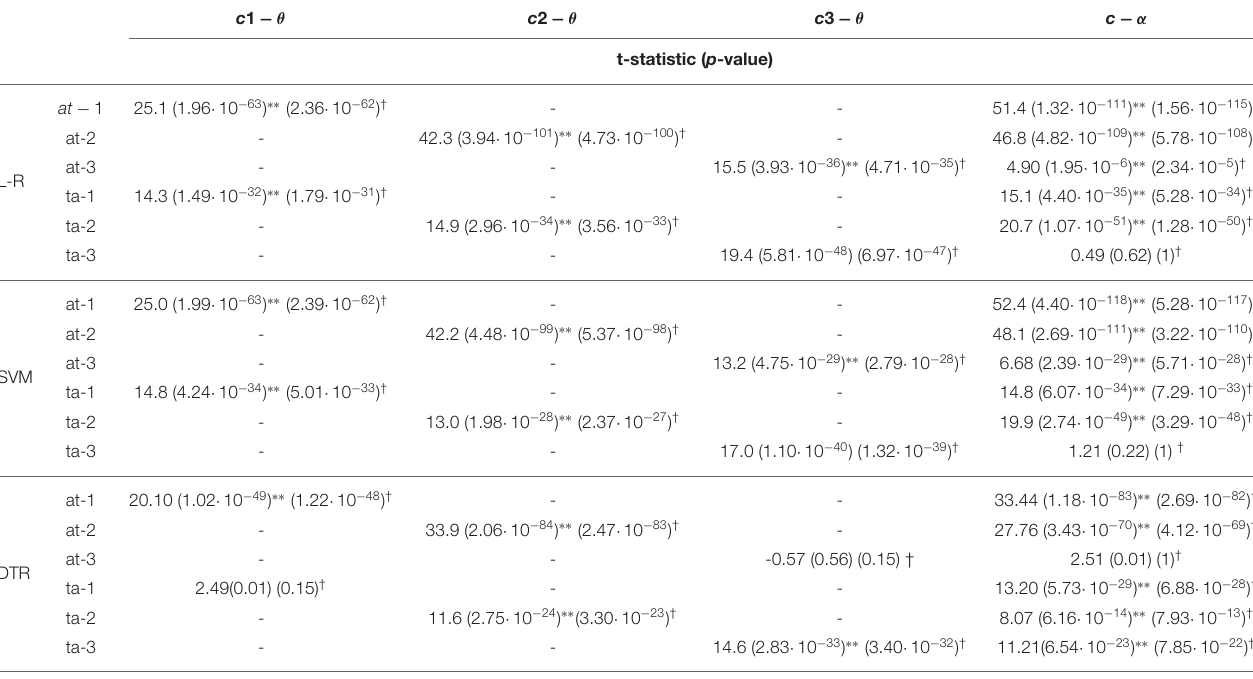
TABLE 4 | The two-tailed t -test between the alpha-to-theta and theta-to-alpha ratio indexes with their individual indexes with Bonferroni(†) correction applied, resulting in a significance level set at α = 0.005. c 1 − θ